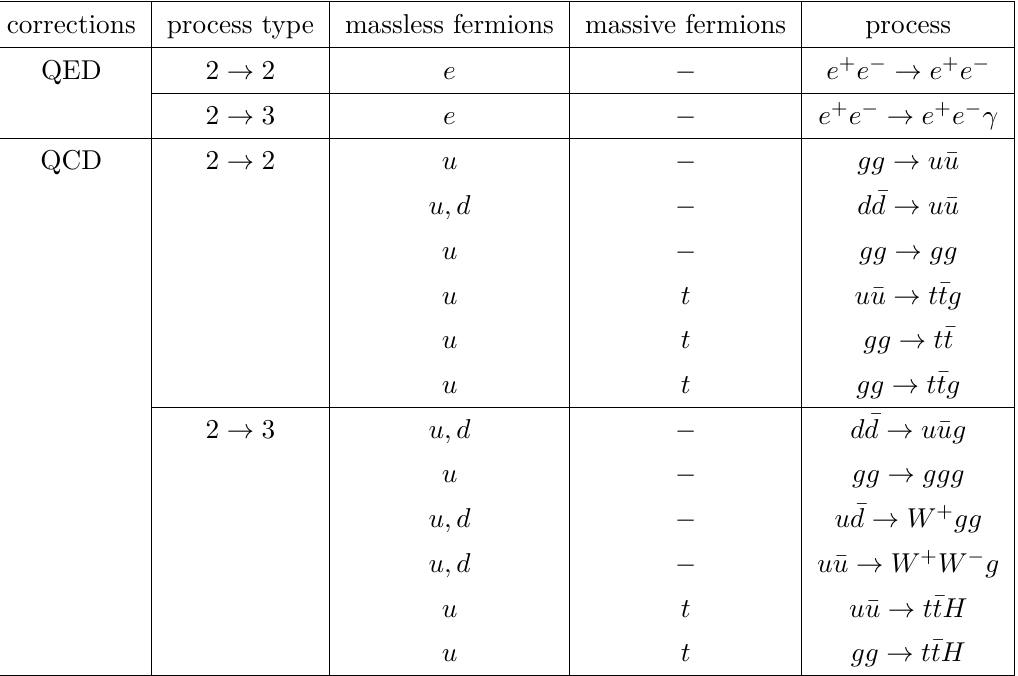
Table 2 . Processes considered for the validation of the two-loop algorithm and for the assessment of its CPU efficiency and memory footprint (see sections 6.3–6.4). The massive and massless states that enter closed fermion loops are listed in the third and fourth columns. Light quarks are implemented as one or two first-generation fields. In processes with a single internal quark field u , light-fermion loops are multiplied with the number of light quarks N l in order to restore all active massless quark flavours. If the doublet ( u, d ) is used, light-fermion loops are multiplied with the number of light generations N l / 2